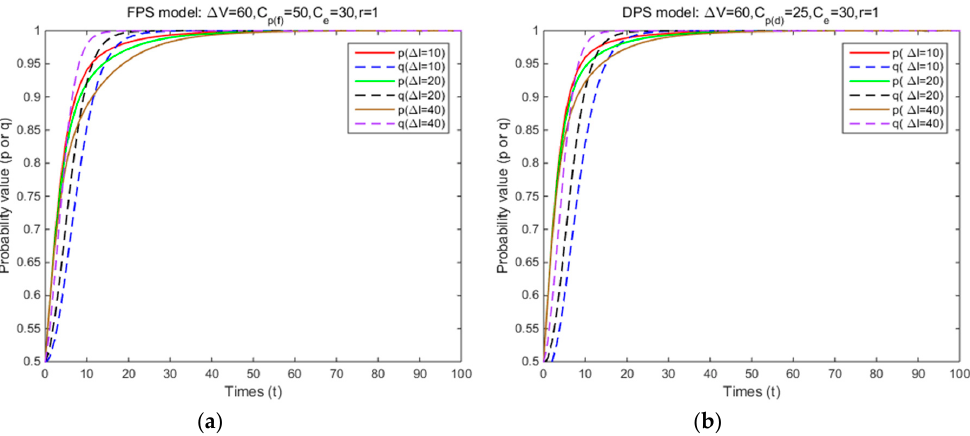
Figure A6. The effects of enforcement cost on strategy probabilities of cyclists and law enforcement under FPS ( a ) and DPS ( b ) (Situation 2).